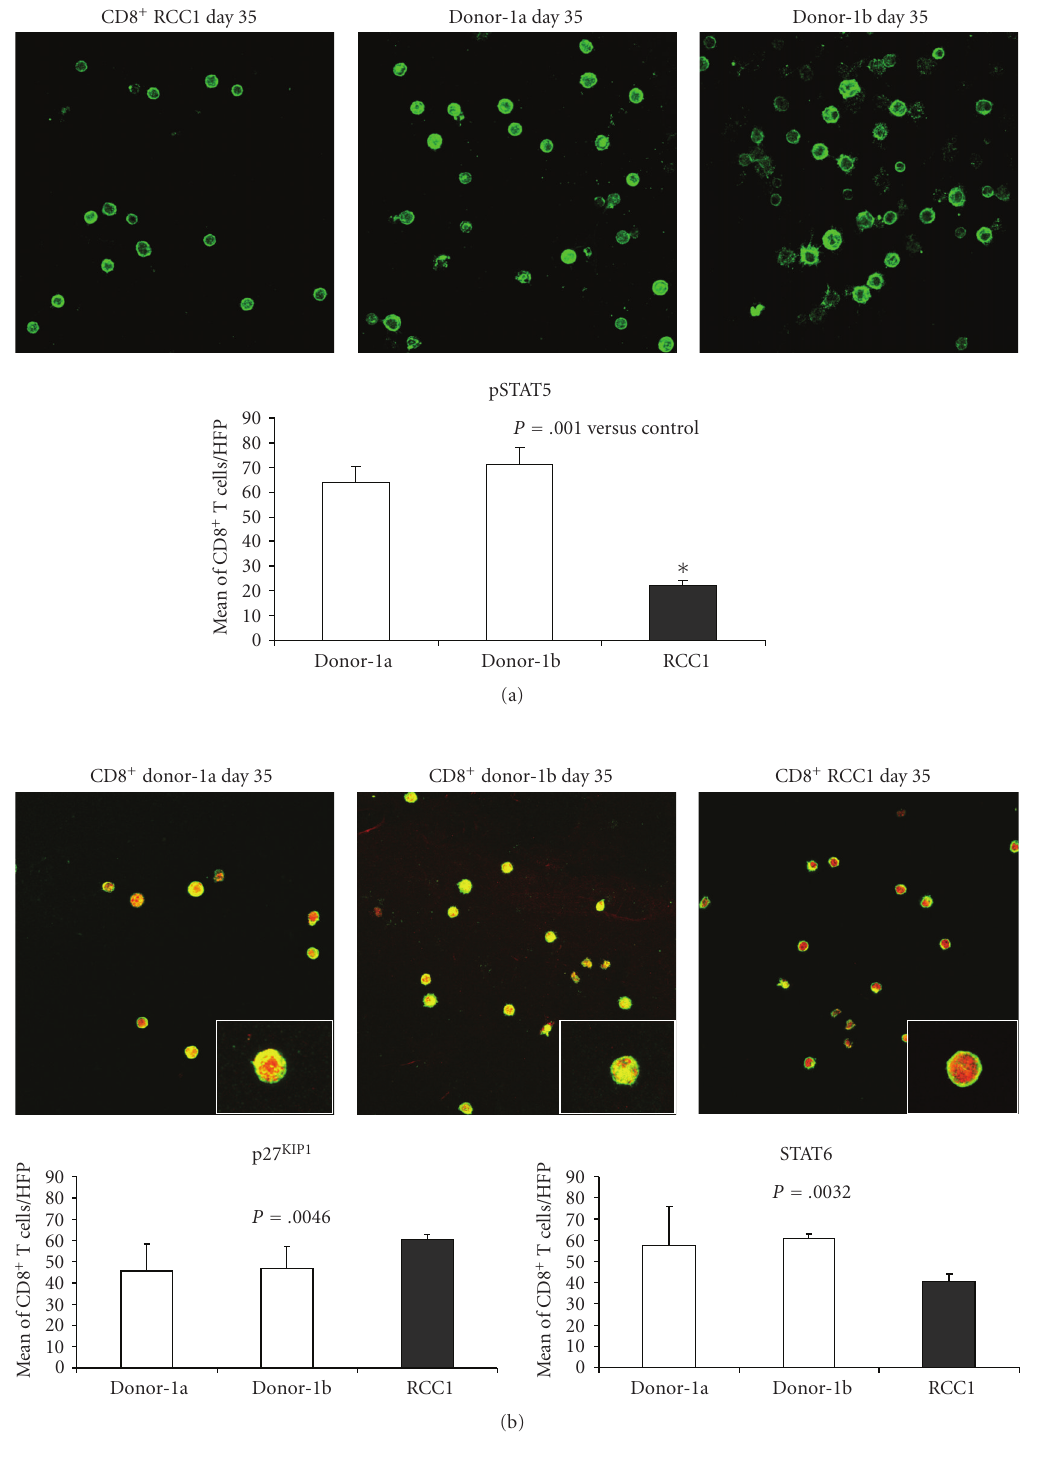
Figure 7: Altered expression of pSTAT5, pSTAT6, and p27 KIP1 in RCC patient CD8 + T cells. (a) Distribution of pSTAT5 evaluated by confocal microscopy on CD8 + T cells of RCC patients and their HLA-matched normal donors, using anti-STAT5 (green) antibodies. (b) The distribution of p-p27 KIP1 and pSTAT6 were evaluated by confocal microscopy on CD8 + T cells of RCC patients and their HLA-matched normal donors, using anti-p-p27 KIP1 (red) anti-STAT6 (green) antibodies. p27 KIP1 /STAT6 interaction results in a yellow staining in the merge. Quantitative analysis of high-power fields (HPFs) in (a) and (b) was carried out by confocal microscopy software (Leica, TCS-SP2). The results were expressed as mean values ± SD. A P -value < . 05 was considered statistically significant. Data are from 1 of 5 experiments that all gave similar